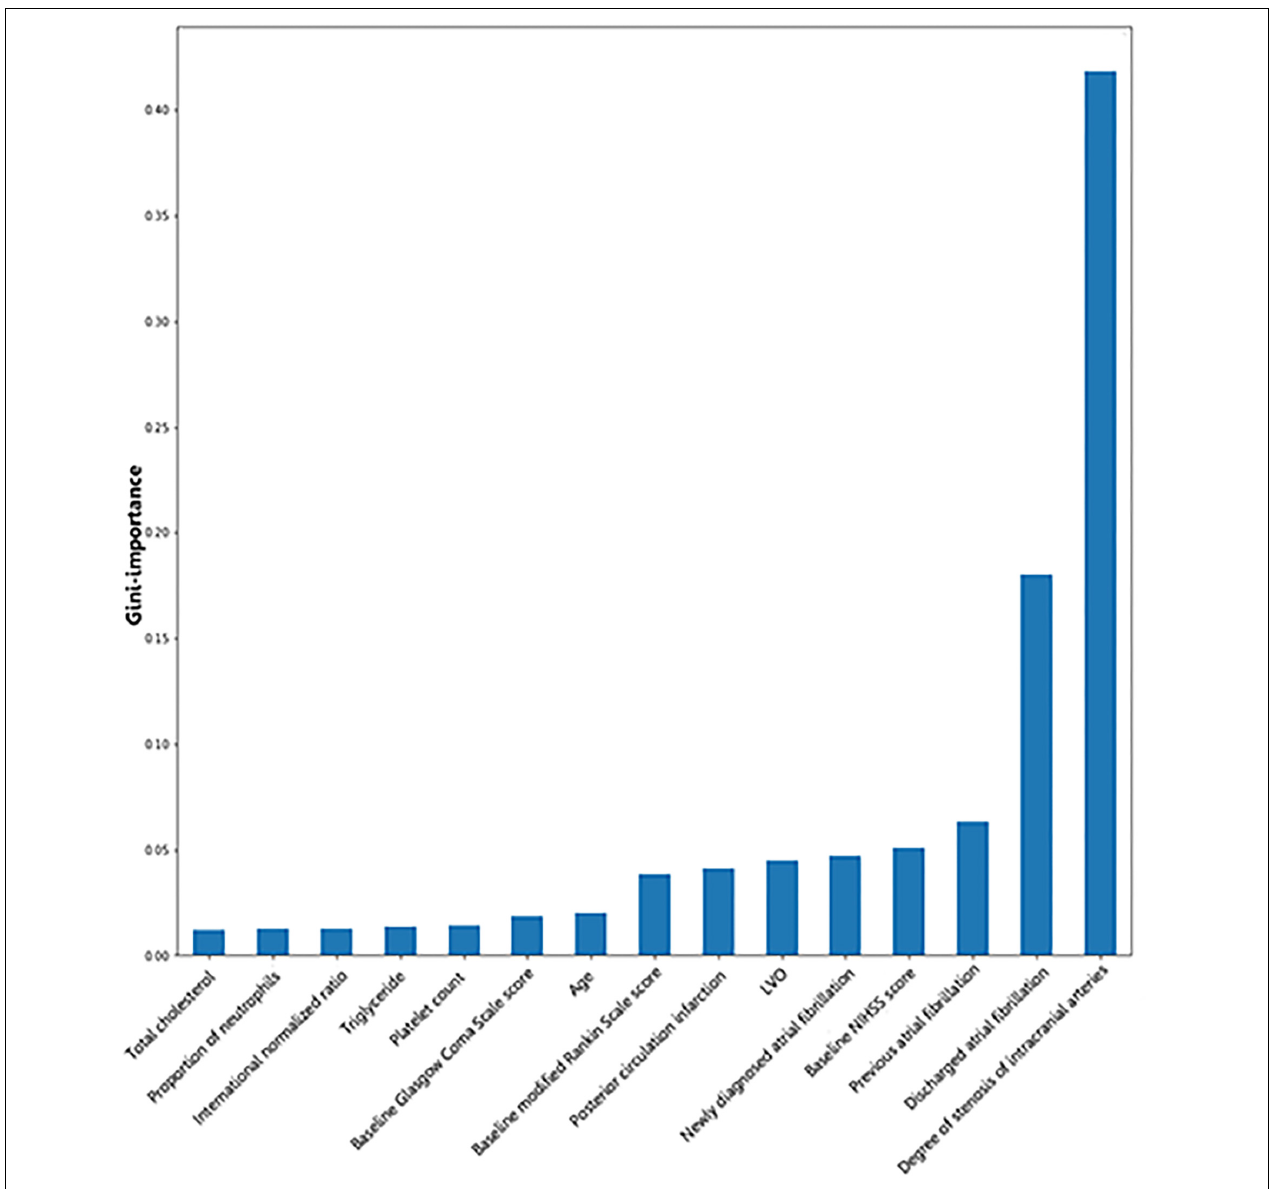
FIGURE 3 | Illustration of features contributing to the identification of SAO by Gini importance values. LVO, large vessel occlusion; NIHSS, National Institutes of Health Stroke Scale; SAO, small-artery occlusion. Gini importance is a measurement of the feature importance in the model; the higher the value of Gini importance is, the more important the feature